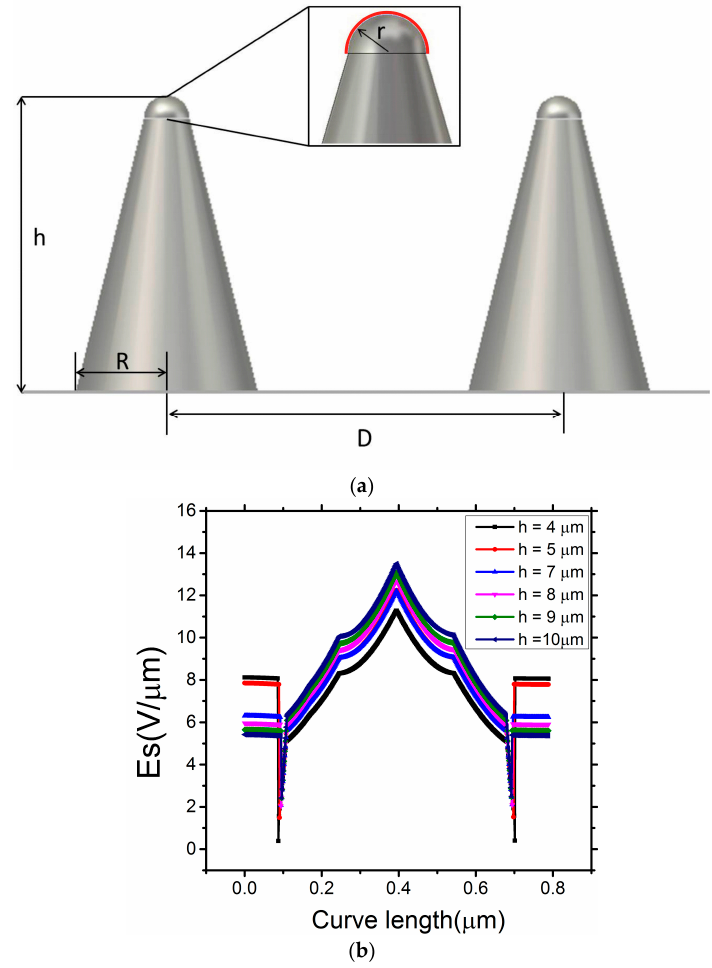
Figure 2. ( a ) Schematic of Mo tip geometry; and ( b ) Electric field verses different height of Mo tip.